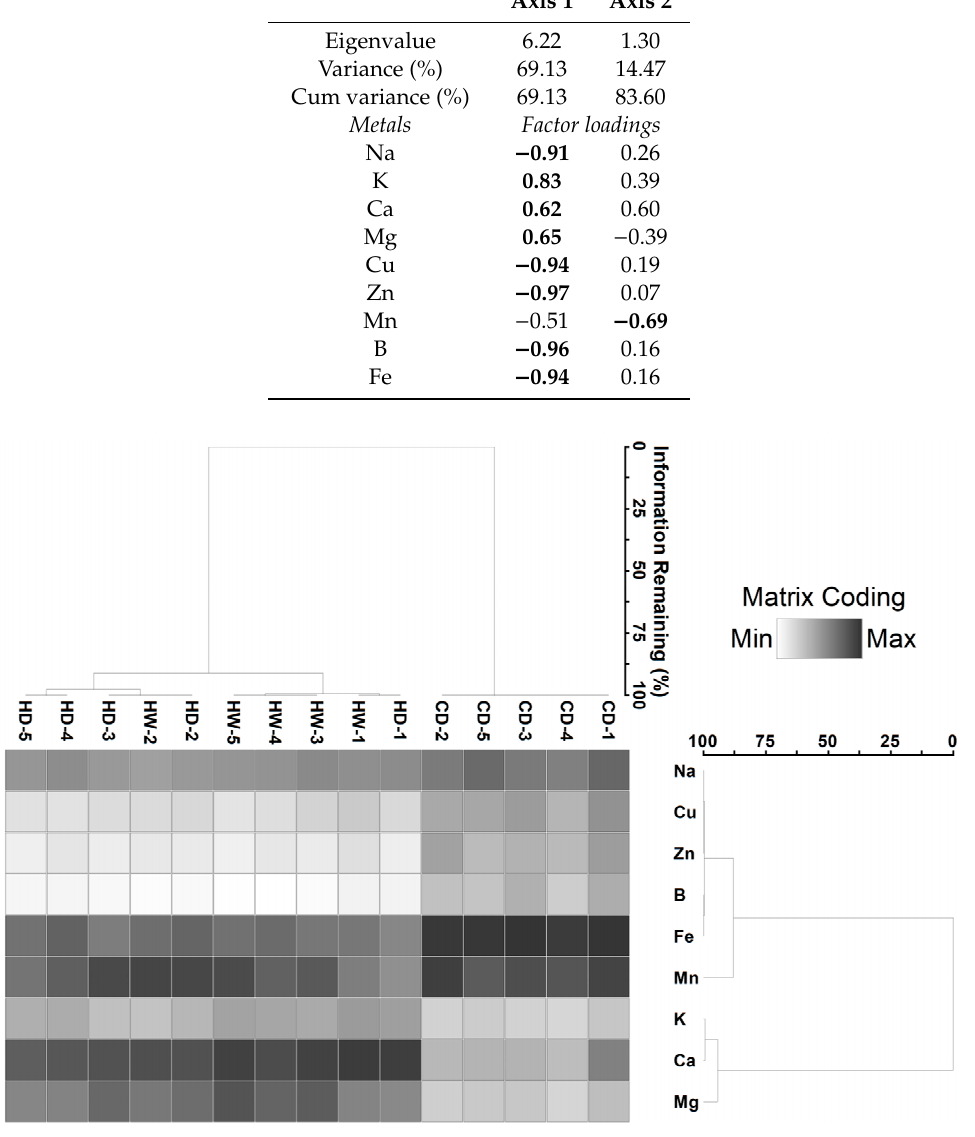
Table 2. Principle component analysis (PCA) results for metal concentrations from five sites (M1–M5) and three seasons (cool-dry, hot-dry, hot-wet) for Mvudi River, South Africa. Factor loadings > 0.5 are highlighted in bold.